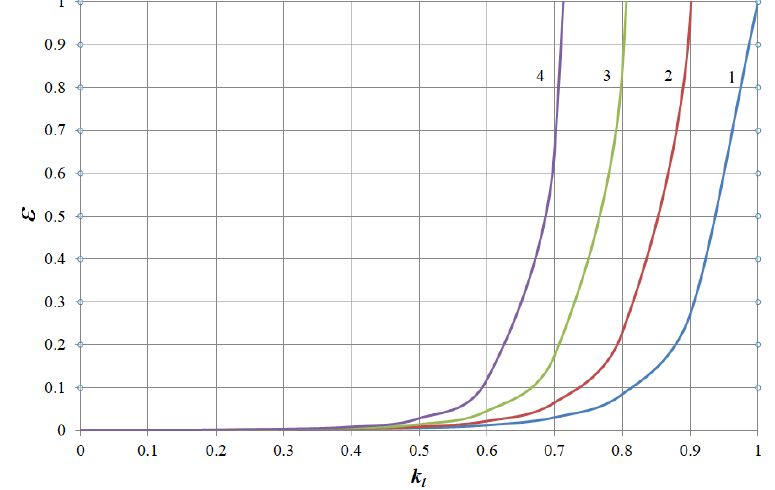
Figure 5. Dependence ε = f ( k l ) at х = 0.